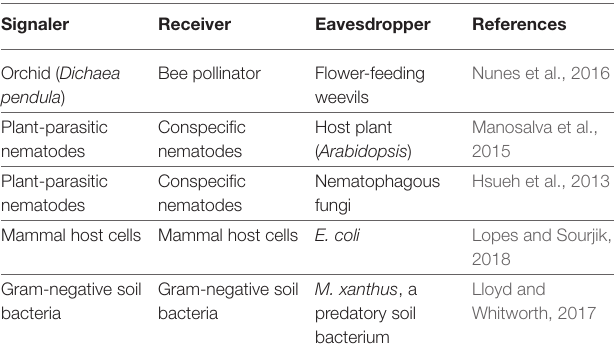
TABLE 2 | Examples of signaler/receiver/eavesdropper relationships in plants and